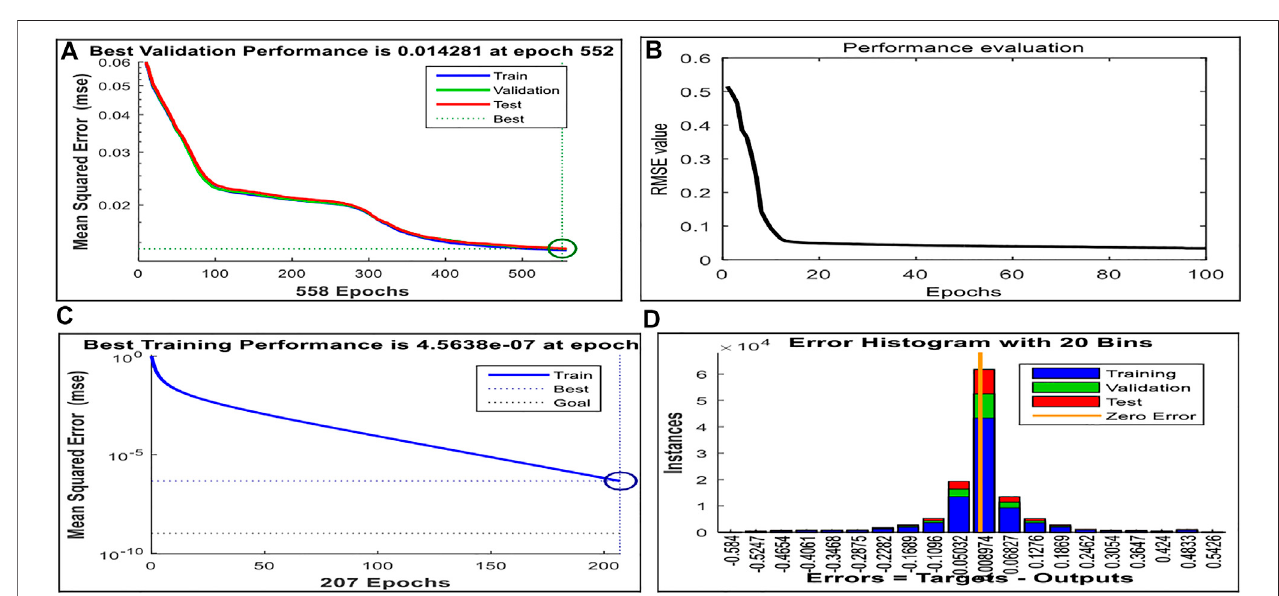
FIGURE 9 | (A – D) Performance testing, testing, and validation of different